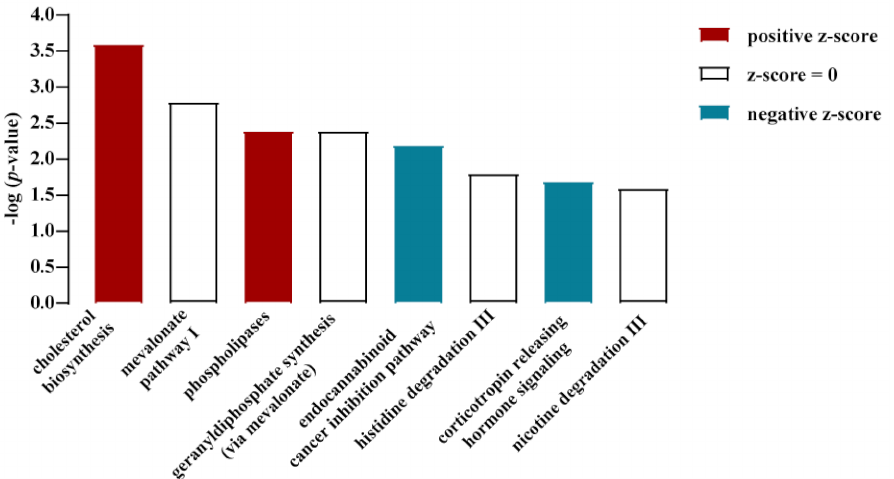
Figure 2. Canonical signaling pathway analysis of RNA-seq data obtained with mHypoA-2/10 cells at low and high glucose levels. For details, see Section